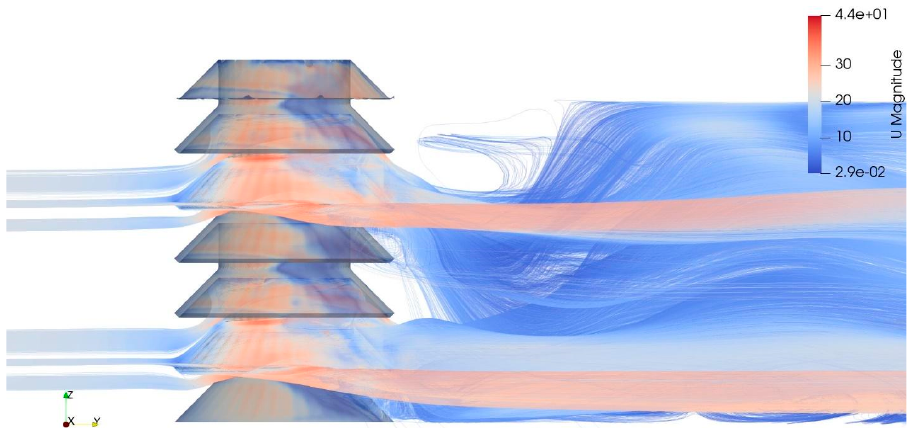
Figure 9. Lateral view showing streamlines colored by their velocity magnitude. To facilitate the visualization, at inlet, the air only passes through the second and fifth fin of the tube.